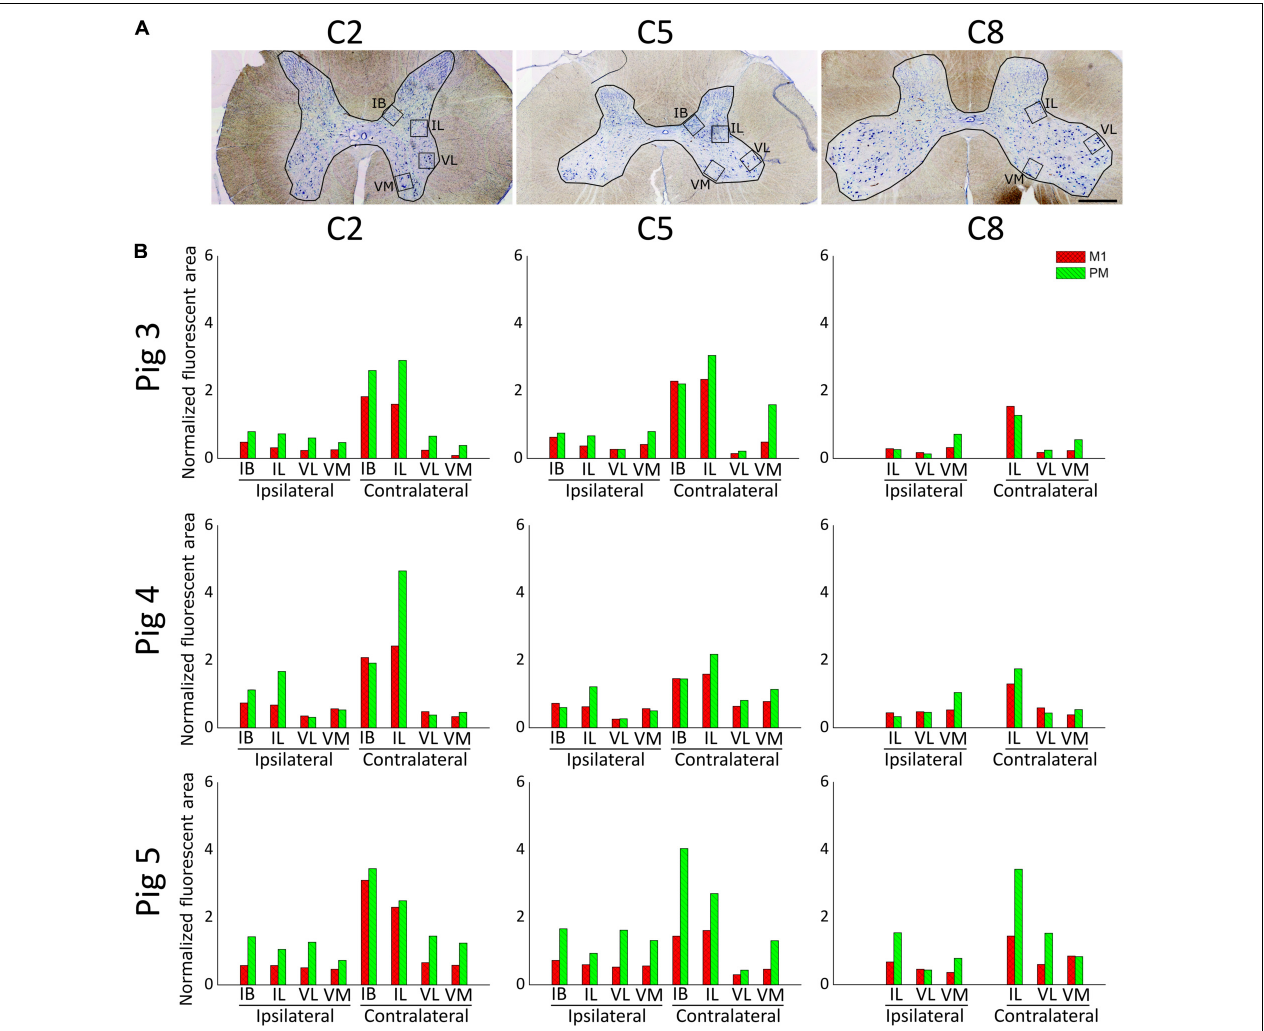
FIGURE 5 | Estimation of spinal gray matter innervation by axons from M1 and premotor cortex (PM) (A) C2, C5, and C8 transversal spinal cord sections processed for Toluidine blue staining. Squares illustrate the regions of the gray matter analyzed. IB, internal basilar nucleus; IL, intermediolateral region; VM, ventromedial region; VL, ventrolateral region. Scale bar, 1 mm. (B) Gray matter innervation represented as the area occupied by CST axonal branches and endings in the regions illustrated in A for the spinal cord segments C2, C5, and C8, normalized to the amount of CST axons counted in C2. Values from M1-arising axons are shown in red, and those from PM-arising axons appear in green. Three tissue sections were analyzed for each data